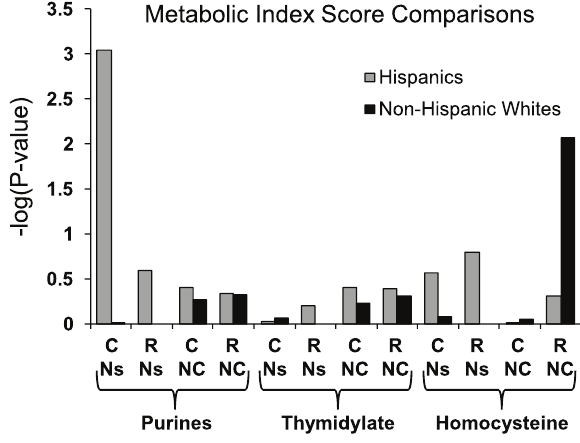
Figure 4. Inferred Metabolic Impact in NTD Cases and Controls. Metabolic Index Scores were calculated for 3 key folate-regulated metabolites (Purines, Thymidylate, and Homocysteine) and differences in the case/control distributions are represented by –log(P-values). Index Scores were derived from alleles summed according to pathway designations (gene sets and directionality; see Figure 3 and Table S3) and P-values following permutation were calculated as described in Methods. The P-values shown are not adjusted for multiple comparison testing. For each metabolite, 4 different subsets of variants were considered to derive Index Scores and are indicated by the following abbreviations on the x-axis: C, common alleles (MAF . 2.5%); R, rare alleles (MAF # 2.5%); Ns, nonsynonymous variants; NC, non-coding variants. Results are shown for Hispanic and non-Hispanic white subsets of the study